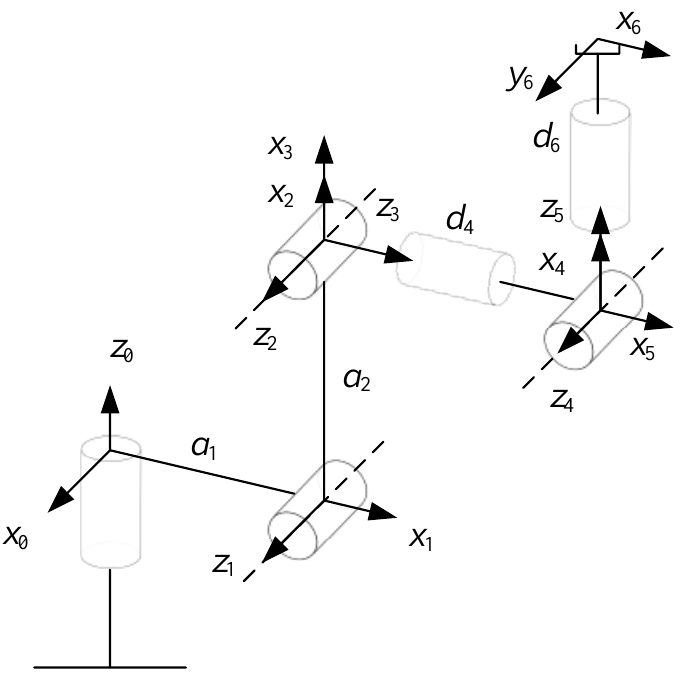
Figure 2. RS010N Robot DH coordinate system.